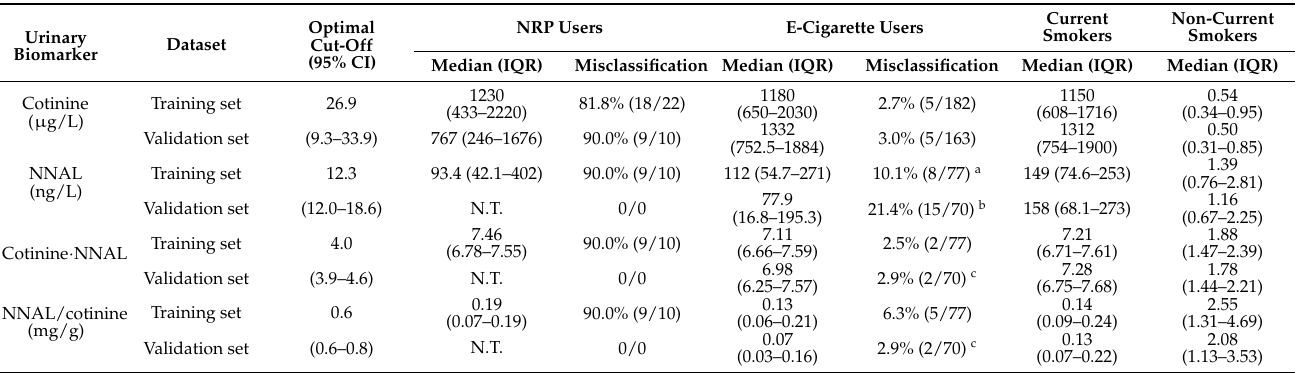
Table 3. A comparison of the diagnostic performance of four urinary biomarkers in e-cigarette users and NRP users.